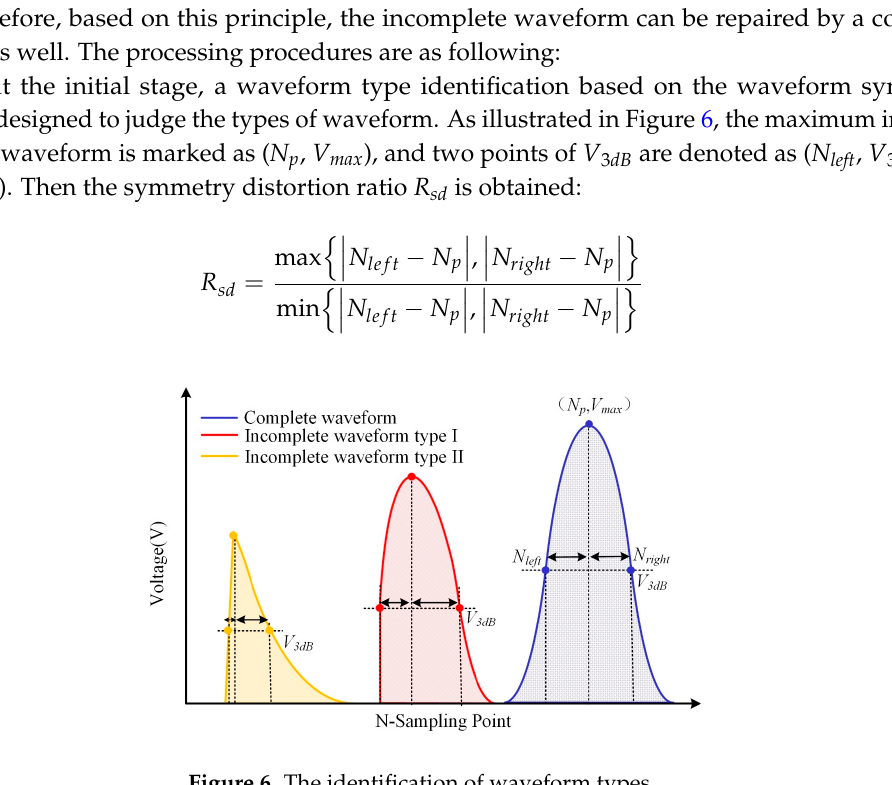
Figure 6. The identification of waveform types.